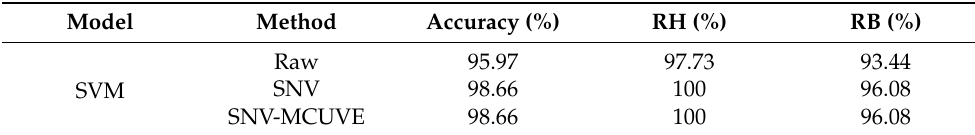
Table 3. The results of SVM discriminative models for pear quality based on different modeling variables.